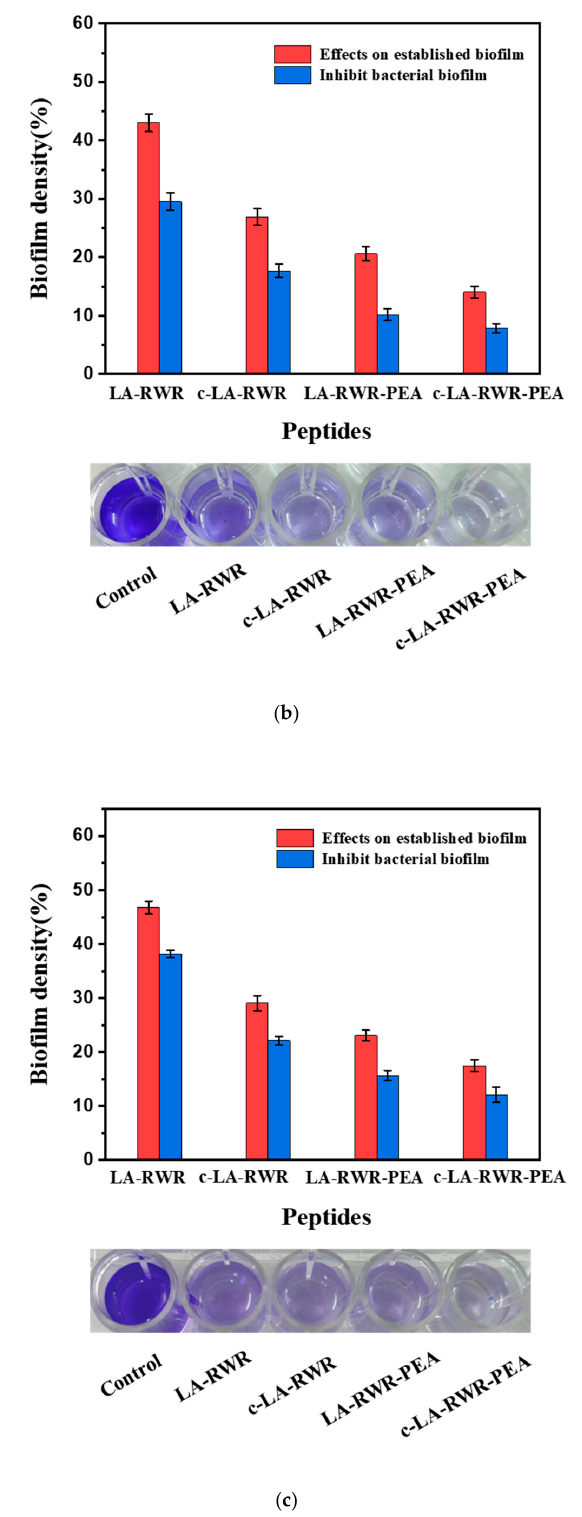
Figure 4. Effects of LA-RWR, c-LA-RWR nanoparticles, LA-RWR-PEA, and c-LA-RWR-PEA nanopar- ticles on the biofilm activities of ( a ) E. coli , ( b ) S. aureus , and ( c ) MRSA. Bacteria were grown in medium to a concentration of 10 7 CFU/mL, placed in 24-well plates, and incubated at 37 ◦ C for 48 h to form